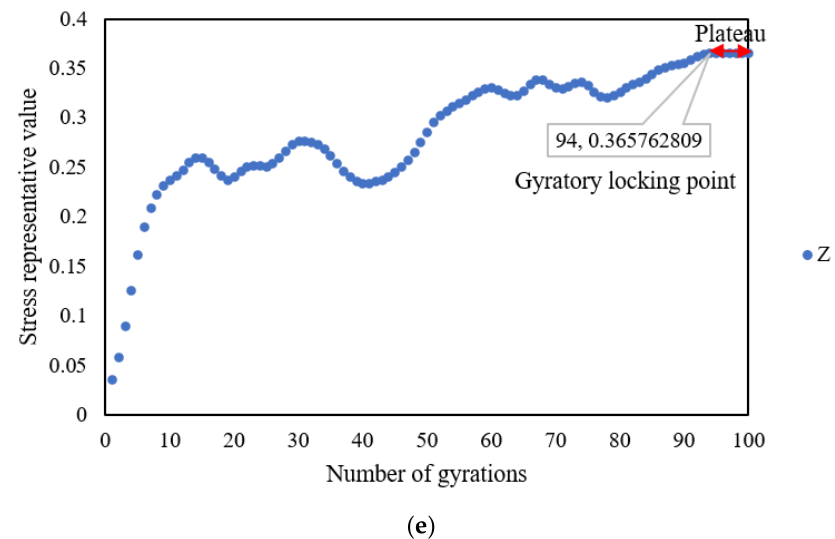
Figure 7. Gyratory locking point determination procedure: ( a ) original data in the time domain, ( b ) original data in the frequency domain, ( c ) post-processed data in the frequency domain, ( d ) post- processed data in the time domain, and ( e ) Z -axis representative stress value curve.